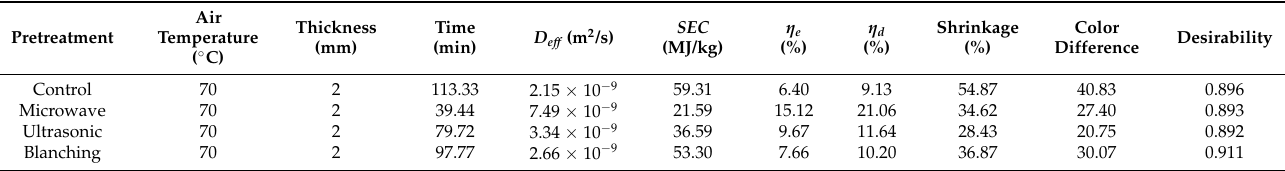
Table 8. Optimization of the response parameters for turnip drying under an HCIR dryer with different pretreatments by RSM.